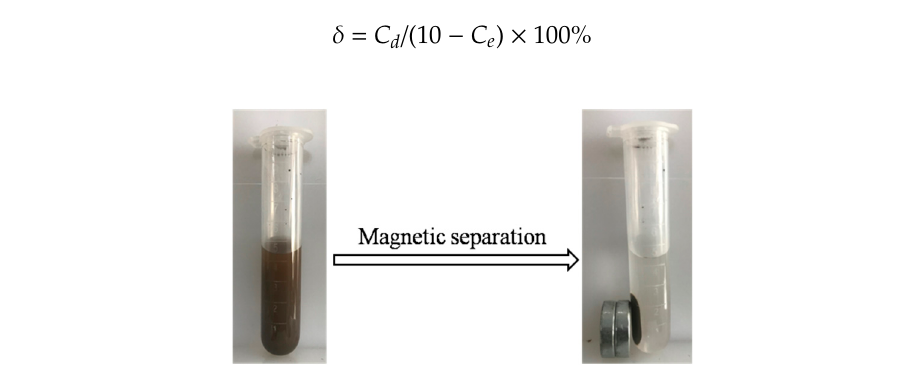
Figure 1. Separation of the supernatant by an external magnetic field. Table 1. Experimental conditions during the adsorption of catechol.